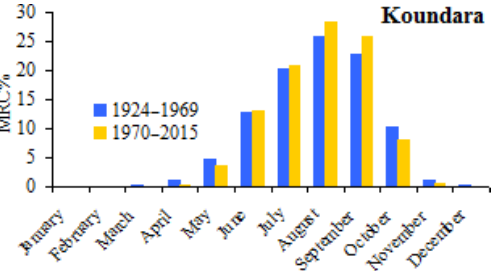
Figure 8. Temporal evolution of MRC during pre-break and post- break at Koundara